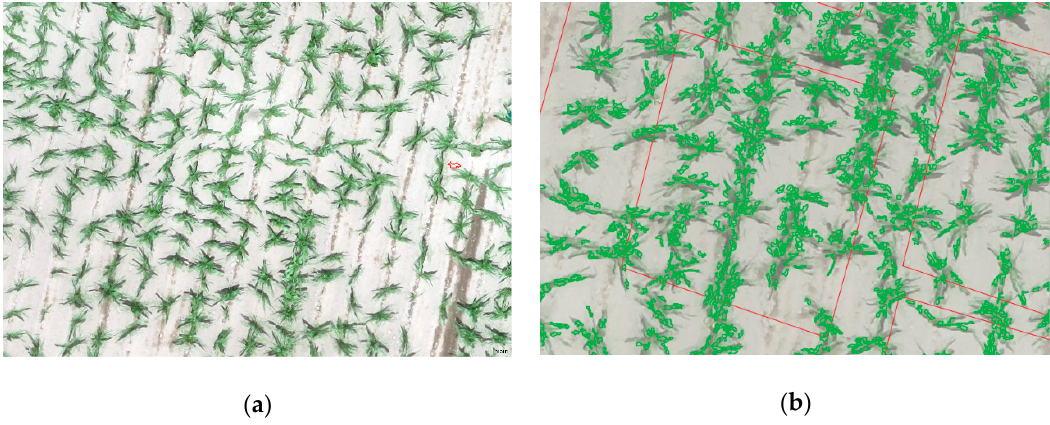
Figure 3. Segmentation and classification of objects present in the orthomosaics for the extraction of pixels belonging to and classified as corn plants: ( a ) image of the crop without segmentation and classification; ( b ) image of the crop with a shape of polygons generated from the segmented and classified pixels of corn plants.